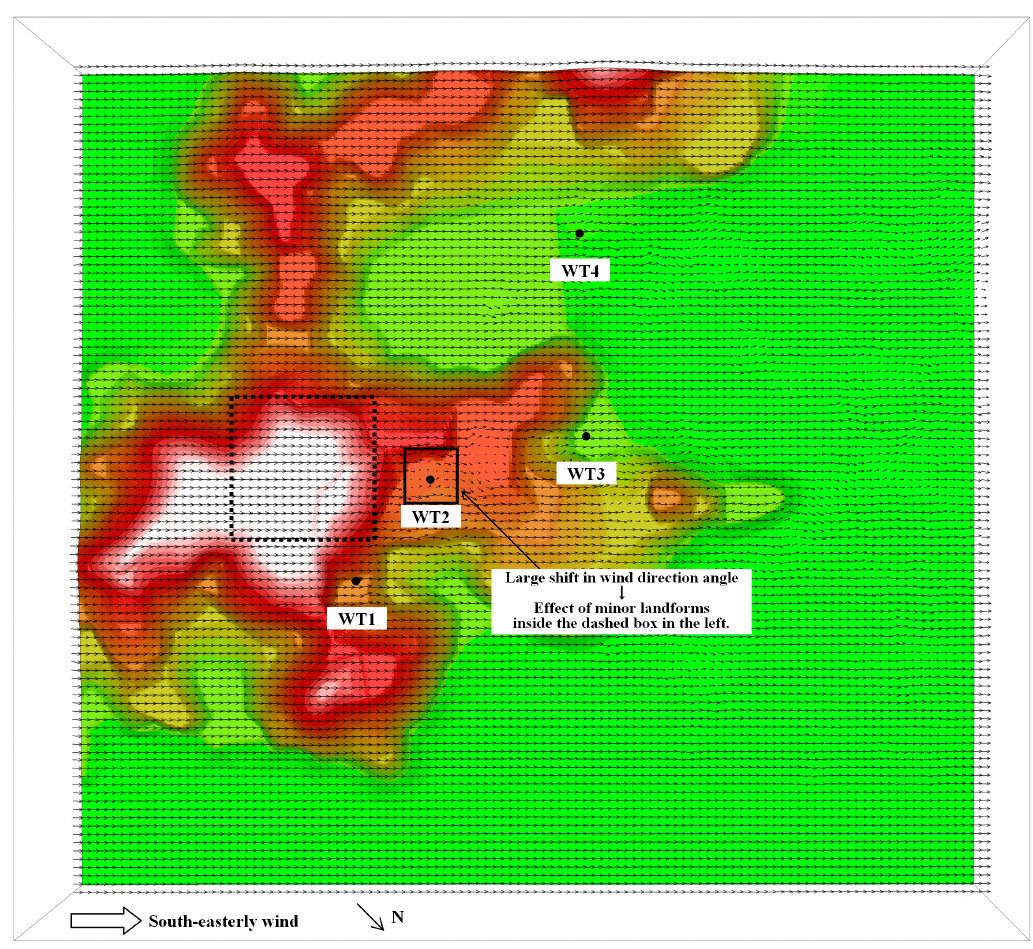
Figure 11. Wind velocity vectors at the wind turbine hub-height (78 m). Instantaneous field from the time indicated by “A” in Figure 10.